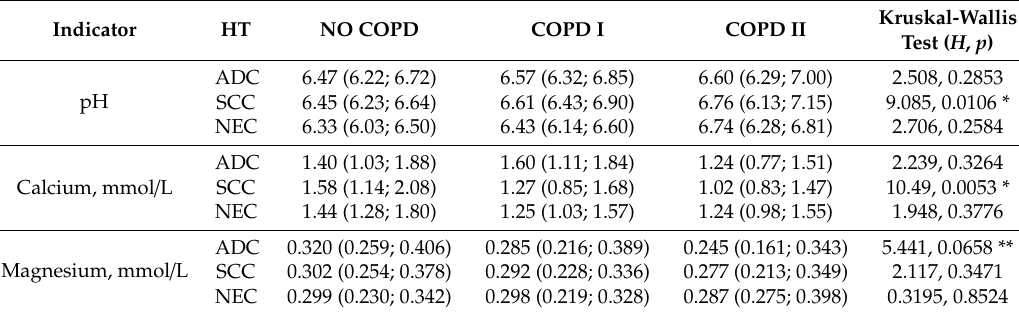
Table 3. Metabolic profile of saliva in patients with lung cancer of various histological types depending on the presence / absence of